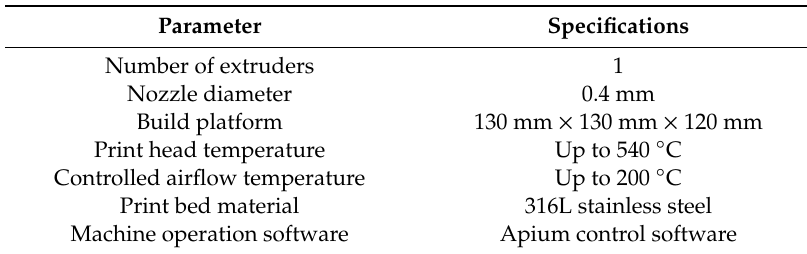
Table 1. Technical specifications of the fused filament fabrication (FFF) polyetheretherketone (PEEK) three-dimensional (3D)